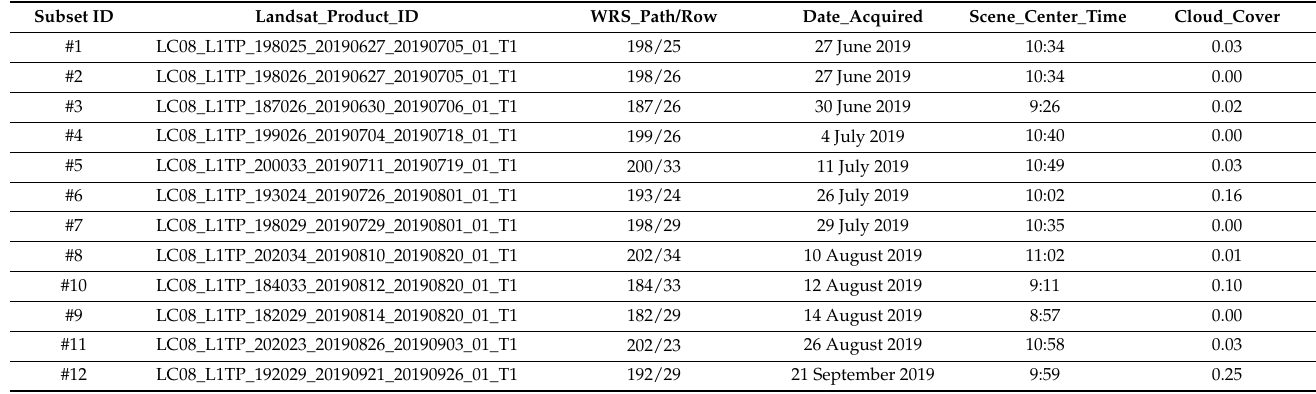
Table 1. List of L8 images used for SaSbEM validation. For the meaning of the L8 metadata fields reported in the table, refer to